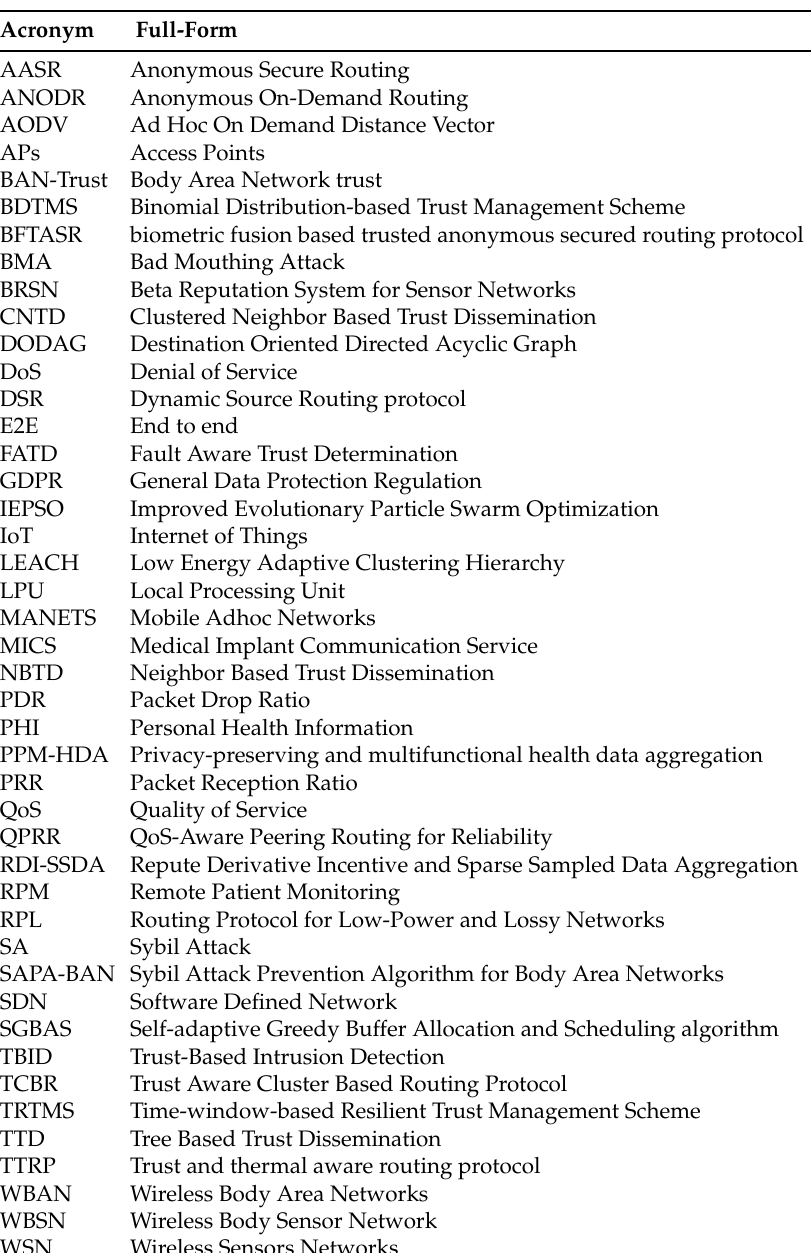
Table 7. List of